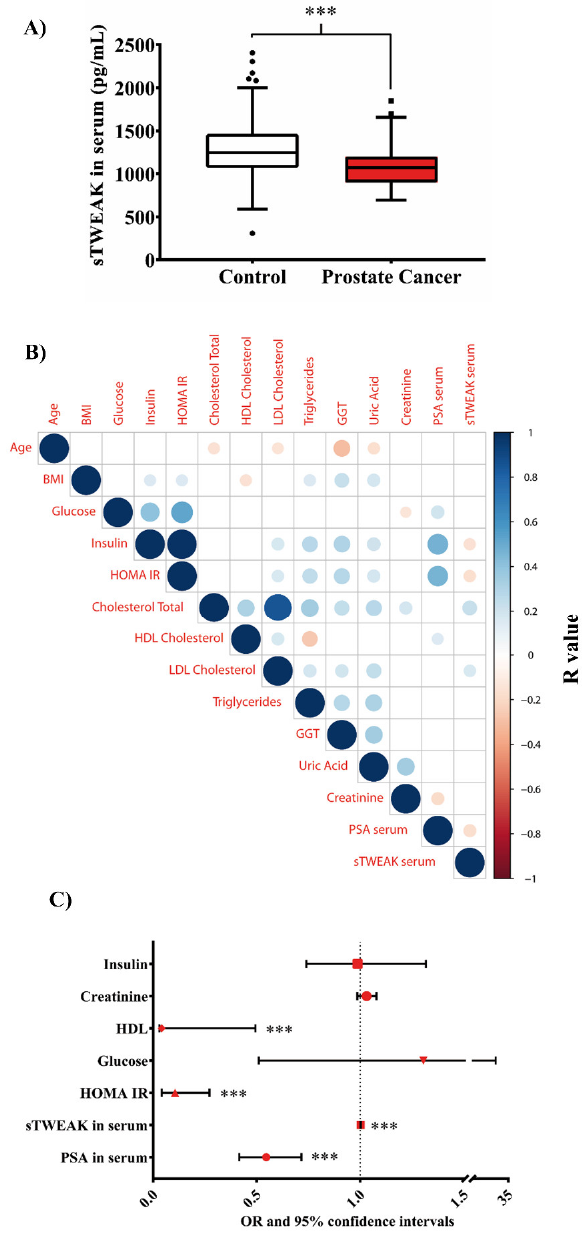
Figure 1. Circulating serum levels of sTWEAK in PCa. ( A ) Box plot (each box shows the median, quartiles and extreme values) representation of the sTWEAK serum levels in the control and PCa cohorts. *** p < 0.001. ( B ) Spearman’s correlation matrix. Positive correlations are displayed in graded blue colors and negative correlations in graded red colors. Correlations with p -values ≥ 0.05 are considered as insignificant and are left blank. The color intensity and the size of the circle are proportional to the correlation coefficients. On the right side of the correlogram, the color legend shows the correlation coefficients and the corresponding colors. ( C ) Relationship between PCa and clinical, anthropometric and analytical parameters. Odds ratios (OR values in different red shapes for each parameter) and 95% confidence intervals. Dotted horizontal line: OR greater than 1 indicates that variable is more likely to occur in PCa and, an OR less than 1 indicates that variable is less likely to occur in PCa. *** p < 0.001. Abbreviations: BMI, body mass index; HOMA-IR, homeostatic model assessment for insulin resistance; HDL, high-density lipoprotein; LDL, low-density lipoprotein; GGT, gamma glutamyltransferase; PSA, prostate-specific antigen; sTWEAK, soluble tumor necrosis factor-like weak inducer of apoptosis .